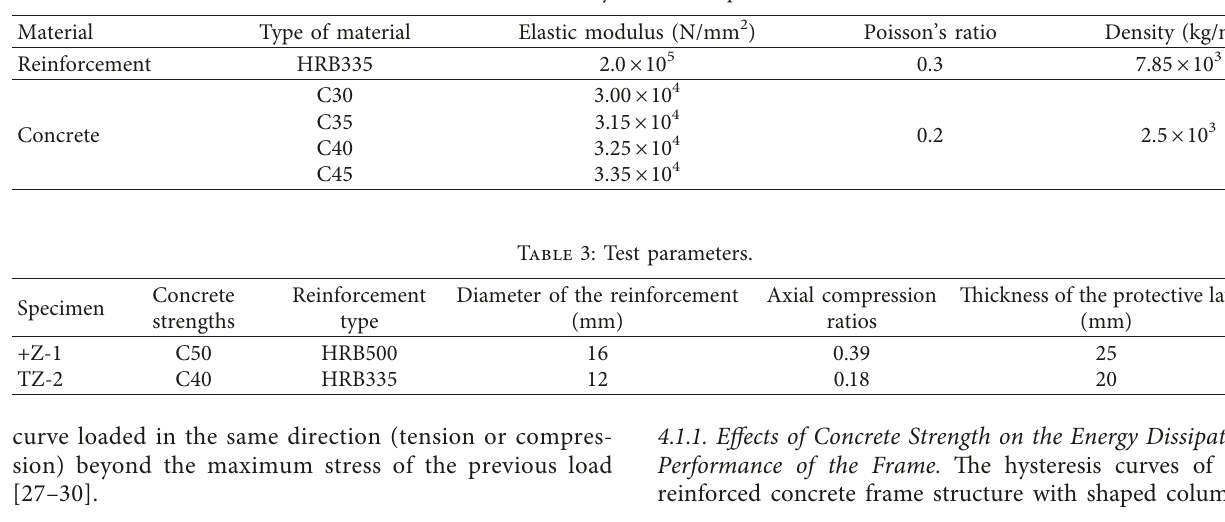
Figure 4: Schematic diagrams illustrating the procedure for model establishment. (a) Model of a cross-shaped column. (b) Mesh of the cross-shaped column. (c) Addition of constraints. Table 2: Summary of material parameters.